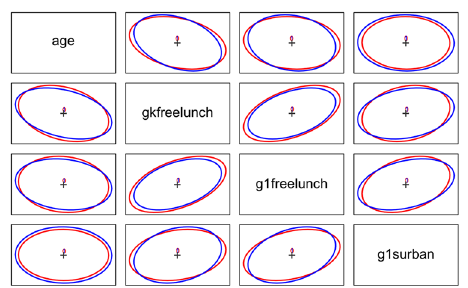
Figure A3: Pairwise data ellipses for the STAR data , centered at the origin. This view allows to compare the variances and covariances for all pairs of